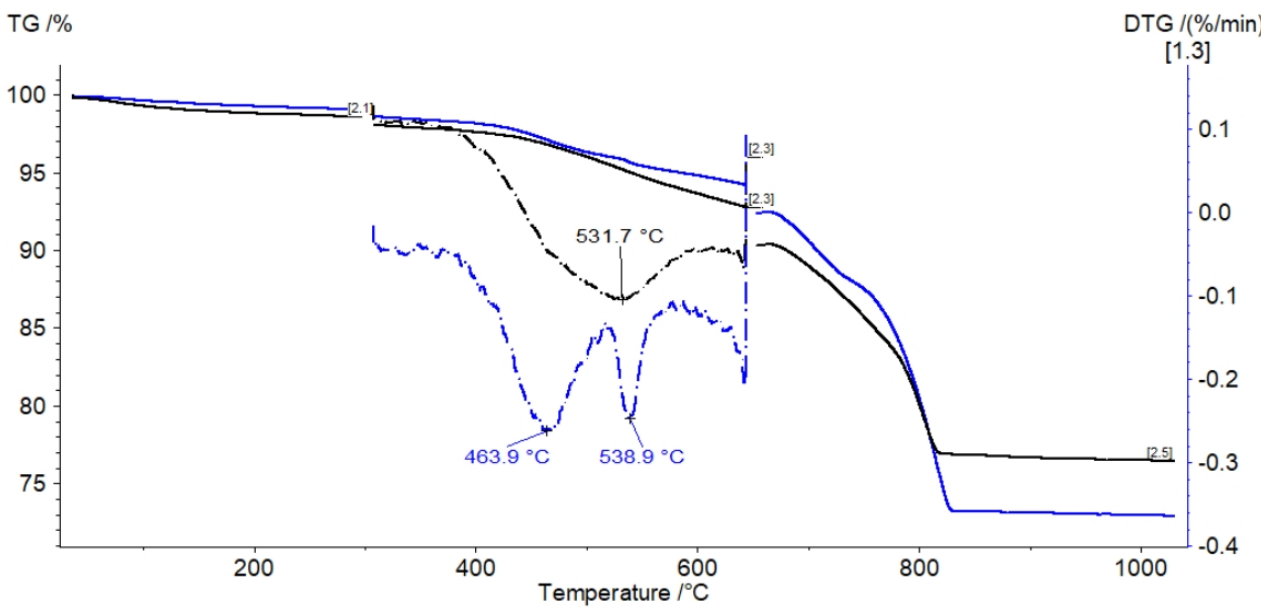
Figure 5. Comparison of TG curves (solid line) and DTG curves (dashed lines) for menilite layer samples (sample 5 in blue and sample 7 in black).